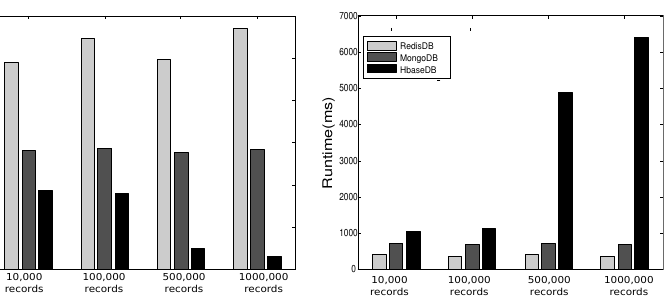
Figure 13. (A) Read/update ratio: 50/50.